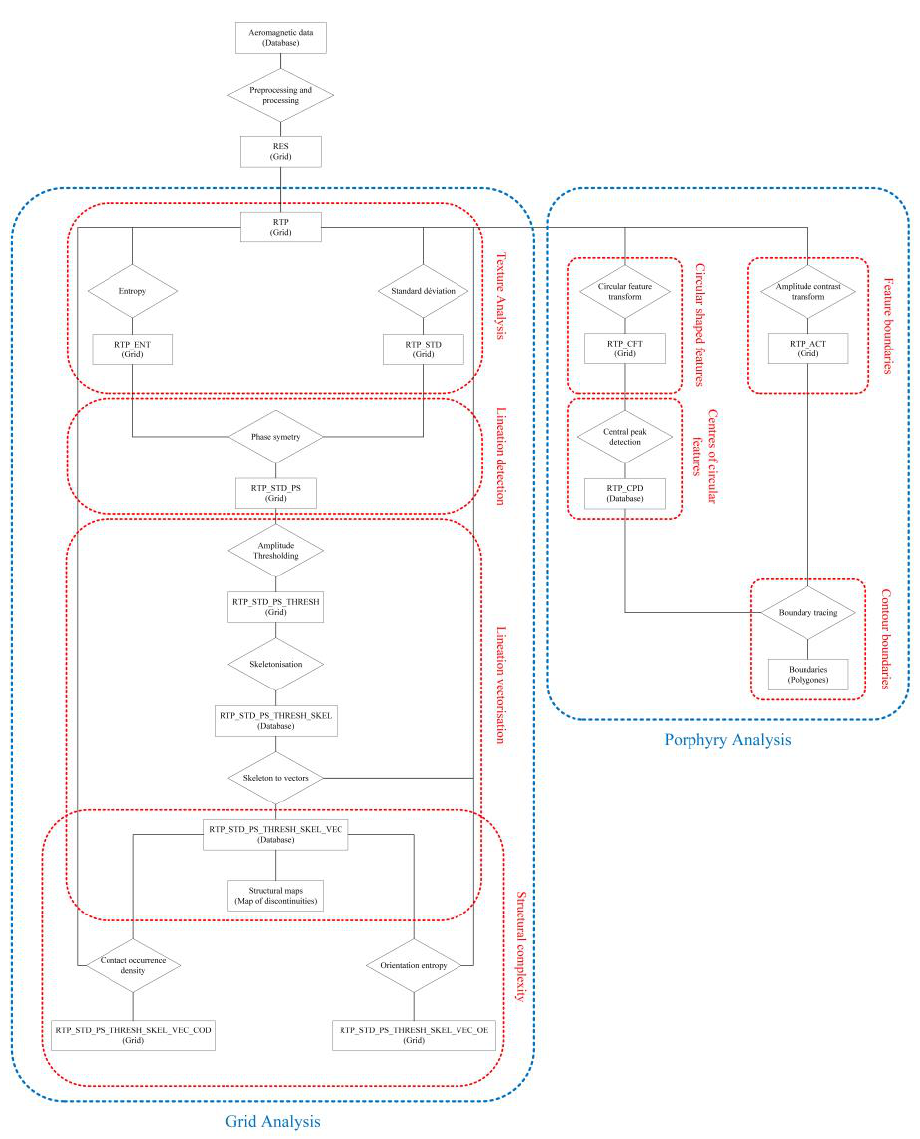
Figure 10. Flowchart of the processing method.